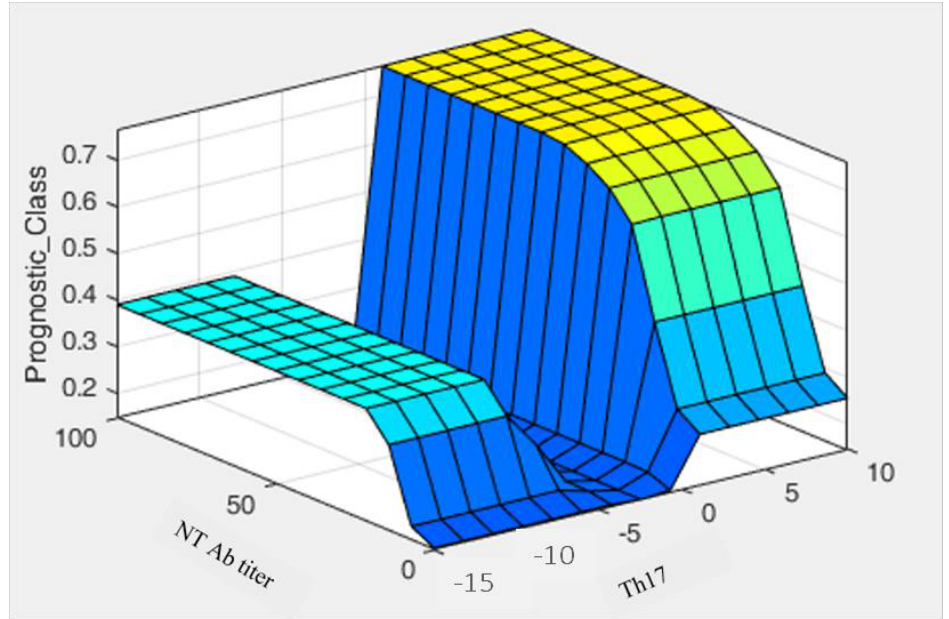
Figure 7. Graphical representation of a decision rule showing neutralizing antibody titer and Th17 population. Fuzzy MATLAB Toolbox and exploited the Mamdani model were used to generate the fuzzy algorithm.